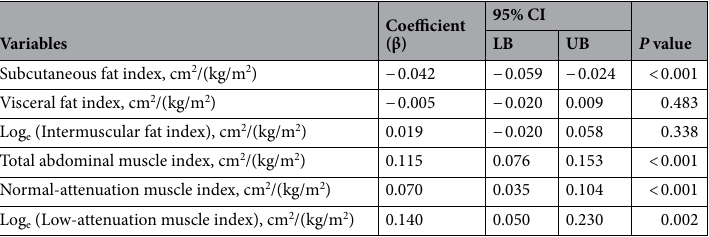
Table 3. Multivariable linear regression analysis to determine the relationship with log e -transformed testosterone (abdominal body composition). CI Confidence interval, LB Lower bound, UB Upper bound. Covariates in the multivariate model include age, individual metabolic factors, albumin, hemoglobin A1c, and C-reactive protein ≥ 2